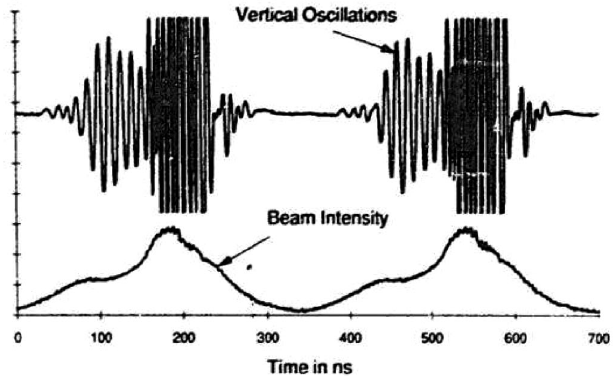
FIG. 7. Observation of PSR instability signals over two suc- cessive turns